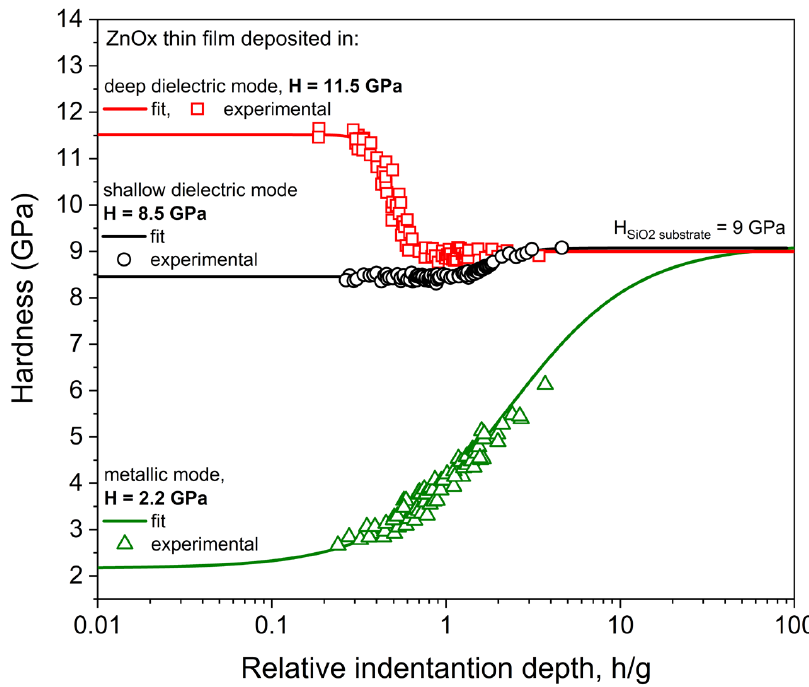
Figure 11. Results of hardness investigations of ZnOx thin films deposited with various technolog- ical parameters.